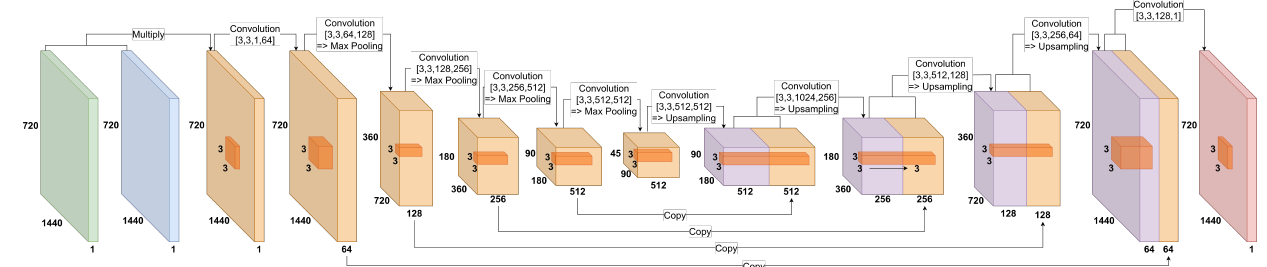
Figure 2. Detailed architecture of the Concrete Autoencoder. The green box indicates the original input physical field. The blue box corresponds to the binary mask that determines sensor locations. The orange blocks present down-sampled features obtained from the measurements at the sensor locations. The purple blocks indicate the up-sampled feature tensors. The red block represents the reconstructed physical field. For each convolution block, the shape of the convolution kernel is presented in the format (kernel height, kernel width, number of input channels, number of output